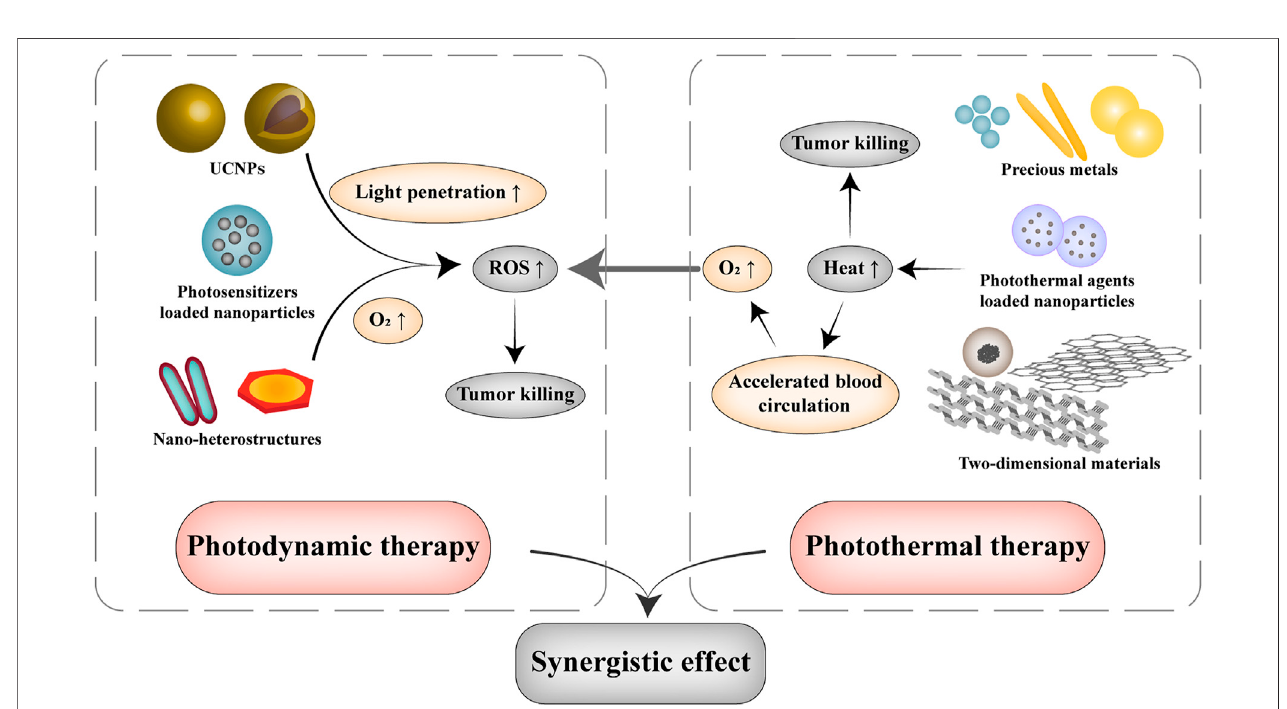
FIGURE 2 | Illustration of nanomaterials used in photothermal therapy and photodynamic therapy. Photodynamic therapy stimulates photosensitizers to produce ROSinanoxygen-dependentmanner.UCNPsareappliedtoenhancethetissuepermeabilityoflightbyconvertingNIRintoUVorvisiblelight,andnanoheterostructures have been proposed forthesimultaneousgenerationofROSand O 2 through electron-hole separation undernormoxiaor hypoxia condition. Photothermaltherapy uses NIRtoexcitenanomaterialswithgoodlight-to-heatconversioncapabilitiesfortumorablation,whichcaneffectivelyacceleratethebloodcirculationandincreasethe oxygen concentration of tumor tissue, which in turn facilitates the performance of photodynamic